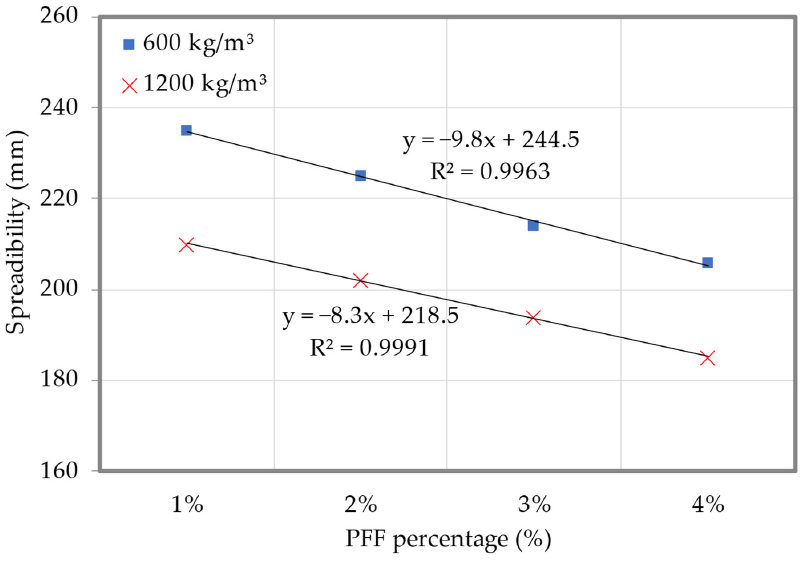
Figure 8. Spreadability of foamed concrete with varying percentages of PFF.